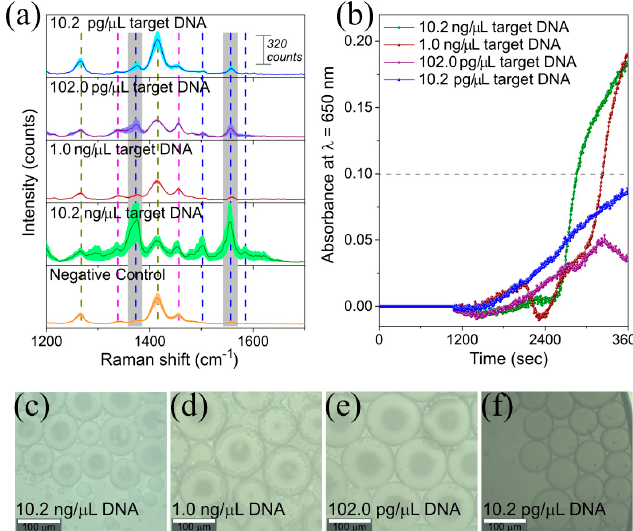
Figure 5. ( a ) Comparison of LAMP-on-a-chip SERS detection with ( b ) LAMP real-time turbidity detection for DNA extracted from L. monocytogenes. LAMP reaction was performed at 62 °C for 60 min with different target DNA concentrations. In the negative control, sterilized water was added instead of extracted DNA. A positive reaction was indicated by the enhancement of SERS signal of 1NAT (i.e. the Raman reporter used in this work) due to the aggregation of 1NAT:GSH:lowTPEG -AuNPs triggered by the complexation of GSH presented on Au surface and pyrophosphate ions that is a byproduct of DNA amplification, with free Mg 2+ in the case of ( a ) and by increasing of absorbance at 650 nm due to formation of magnesium pyrophosphate crystals in ( b ). In the graph shown in ( a ), dashed lines highlight the position of the Raman peaks corresponding to PDMS (dark yellow dashed line) and dNTPs of the master mix (magenta dashed line) and SERS peaks of 1NAT (blue dashed line). Gray shaded areas in ( a ) indicate the selected characteristic peaks of 1NAT (1368 and 1553 cm -1 , ring stretching) to follow the variation of SERS signal respect to the generation of pyrophosphate ions during DNA amplification (see Figure 6). Shadowed area in the spectrum represents the standard error of the mean (SEM) of 6 – 13 SERS spectra. Representative bright field images of stored microdroplets into trapping array are shown after target DNA amplification by LAMP-on-a-chip at a concentration of ( c ) 10.2 ng/µL ( e ) 1.0 ng/µL, ( d ) 102.0 pg/µL and ( f ) 10.2 pg/µL. To study the sensitivity of this method, we performed the LAMP on-a-chip amplification and indirect SERS detection with different concentrations of target DNA (Table 1), subsequently comparing these results with off-chip LAMP real-time turbidity detection (Figures 5 and 6a). Ten- fold serial dilutions of DNA extracted from L. monocytogenes were used as target (initial [DNA] = 10.2 ng/µL, down to 1/1000). All solutions, namely target DNA dilution, LAMP reagents, and oil pre- mixed with a surfactant (2 % w/v), were freshly prepared before being injected into the microfluidic chip. Afterwards, DNA target molecules, LAMP reagents and multifunctional 1NAT:GSH:lowTPEG - AuNPs were encapsulated into water-in-oil-microdroplets, and subsequently stored in the reservoirs. DNA target molecules were amplified during the LAMP process by placing the reservoirs in an oven